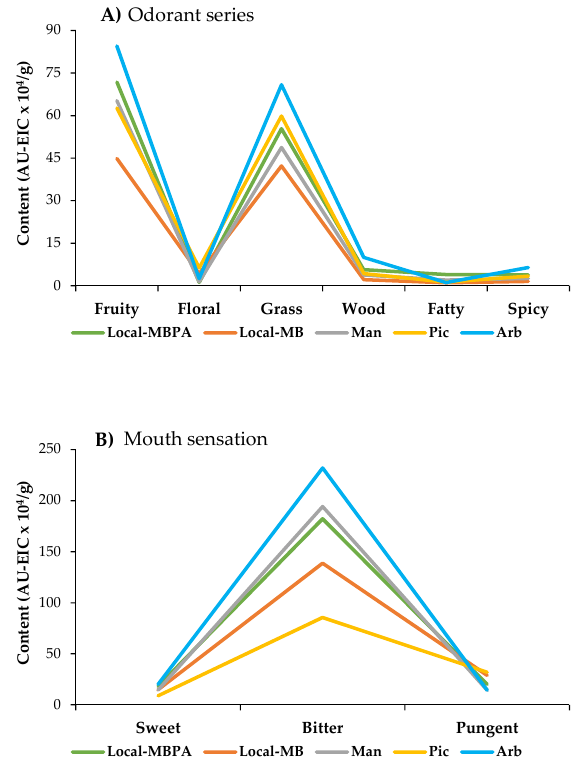
Figure 3. Comparison of odorant series ( A ) and mouth sensation ( B ) in virgin olive oils. Local ‐ MBPA (60% Mansa and Brava, 25% Picual, and 15% Arbequina); Local ‐ MB (60% Mansa and 40% Brava); Man (100% Mansa cultivar); Pic (100% Picual cultivar); Arb (100% Arbequina cultivar). As can be observed, Local ‐ MBPA oils could be characterized by fruity, fatty, and sweet series; Local ‐ MB by floral and pungent series; Mansa oils by bitter series; Picual oils by floral and pungent series; and Arbequina oils by fruity, floral, grass, wood, spicy, sweet, and bitter series. Local ‐ MBPA oils registered higher volatile compounds content than Local ‐ MB oils, probably due to enrichment given by Arbequina cultivar. Studies show that it is possible to discriminate oils according to the growing region and the cultivar of the olives on the basis of volatile profile [15]. 3.4. Sensory Attributes and Consumer Acceptance of Olive Oils The differences in physical and chemical parameters (fatty acids and volatile compounds) found in olive oils involve differences in their organoleptic properties which would have an effect on consumer acceptance. Sensory analysis is very important in the oil industry due to the quality and commercial oil categories being established by trained taste [13], but acceptance and preference evaluations are also very important to evaluate acceptability of new olive oils by consumers. The sensorial attributes considered to evaluate overall liking of olive oils by consumers were color, odor, taste, and flavor, and the intensity values of these sensorial attributes are showed in Figure 4A. The four studied attributes showed significant differences ( P ≤ 0.001) between olive oils. The Local ‐ MB oils presented the highest intensity values for the sensory attributes and Arbequina oils the lowest. Local ‐ MBPC and Picual oils have obtained similar scores by color, taste, and flavor. When the global acceptance was studied (Figure 4B), the consumers had a higher acceptance for Picual (5.4) following of Local ‐ MBPA (5.2) and Local ‐ MB (5.1) oils, but there were not significant differences ( P ≥ 0.05).